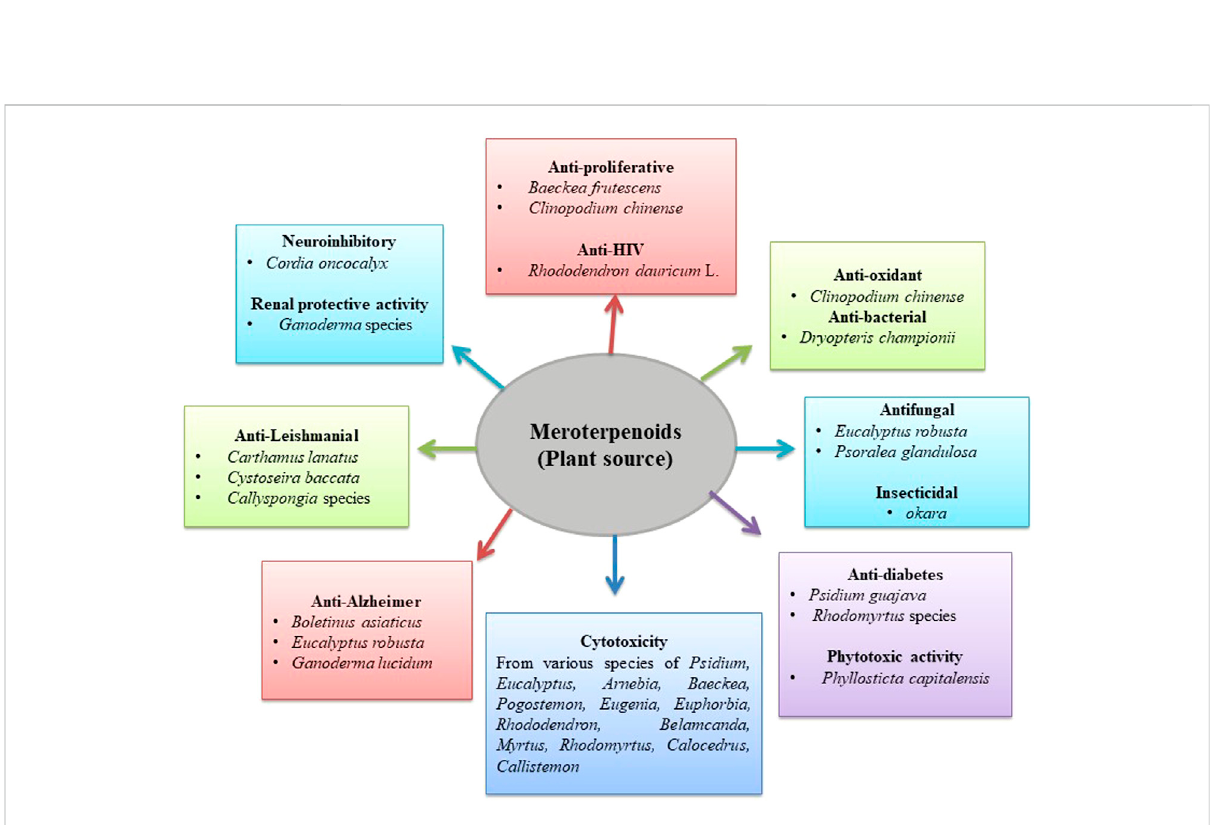
FIGURE 3 Biological activity of plant